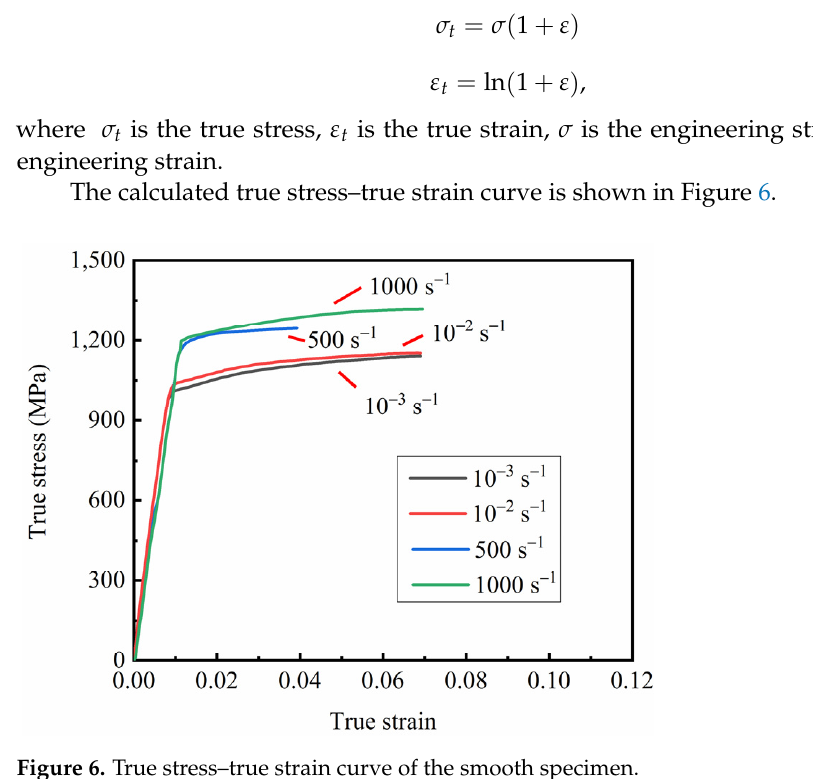
Figure 6. True stress–true strain curve of the smooth specimen.